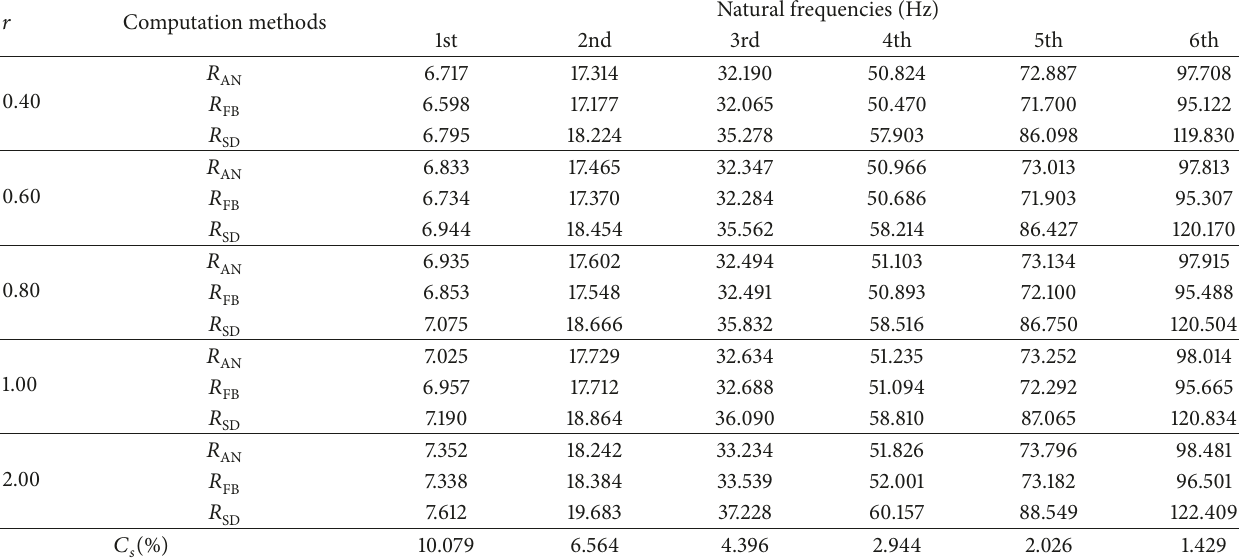
Table 2: Comparison of calculation results between the FBEM and ANSYS model